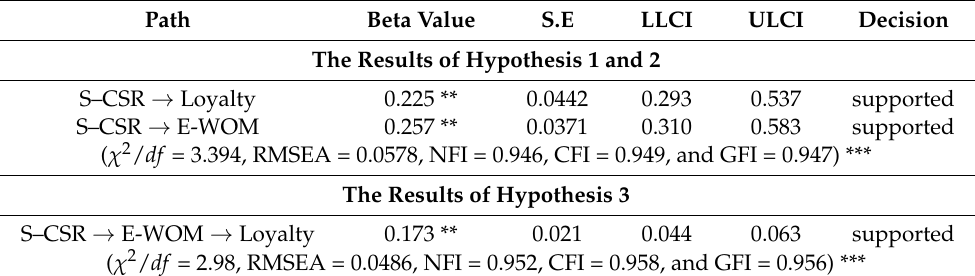
Table 4. Results of the hypotheses